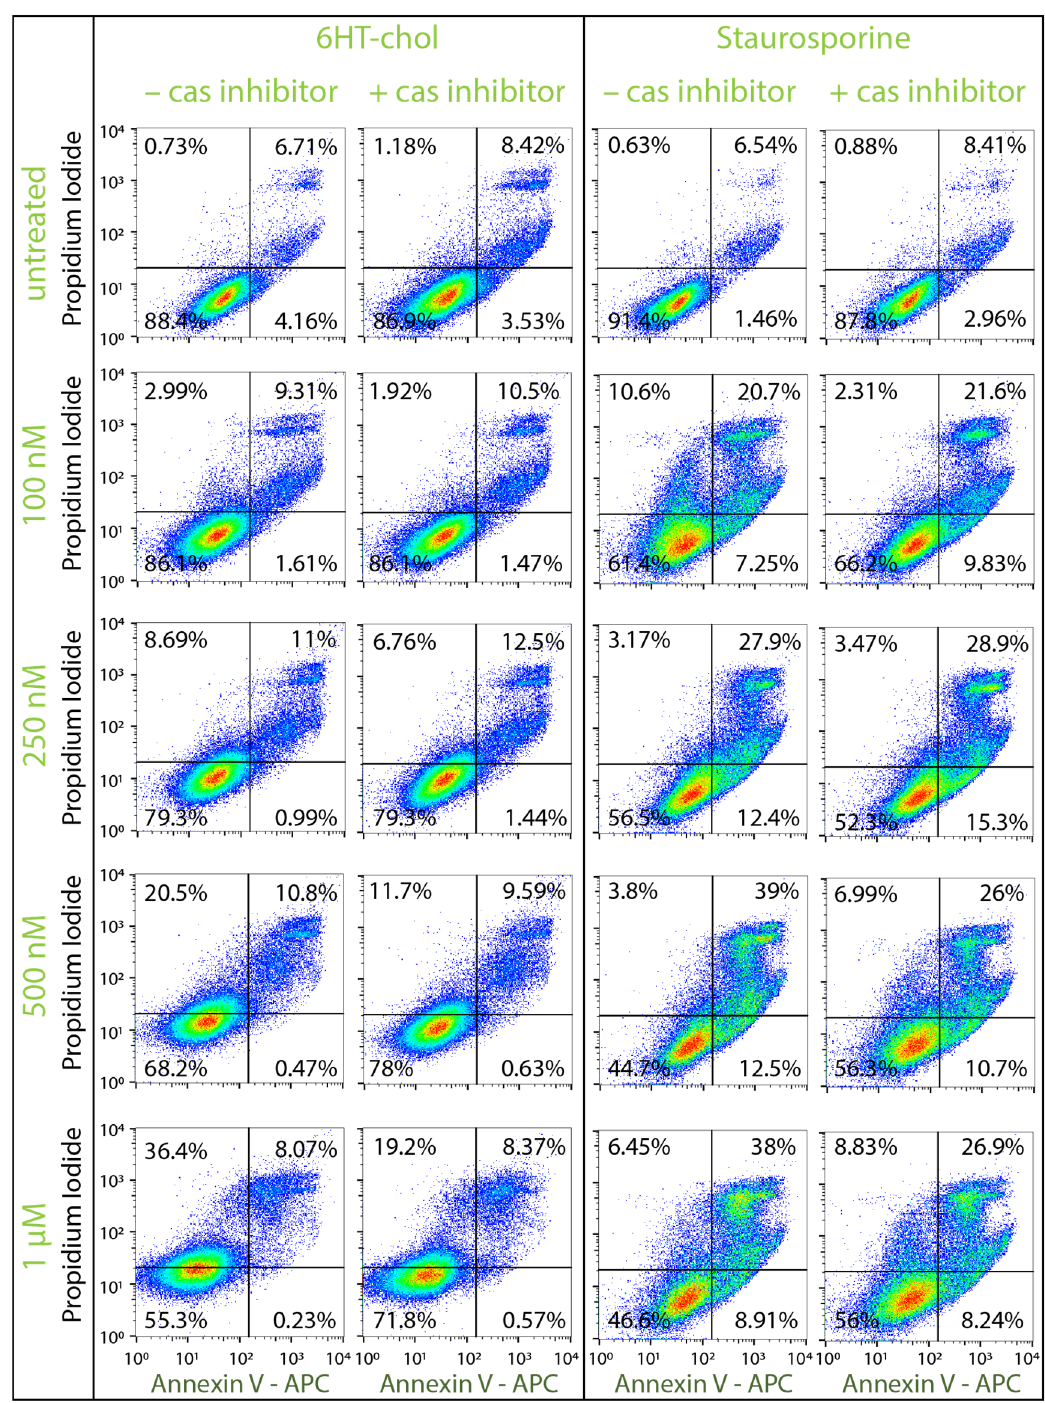
Figure A9. Flow cytometry of the Annexin V/Propidium Iodide-stained cells after 3 h of treatment with cholesterol modified DNA nanotubes (left panel) and the apoptosis inducer, staurosporine (right panel), at a concentration range of 100 nM to 1 µM in the absence or presence of the pan-caspase inhibitor, Z-VAD-FMK (400 µM), as indicated.